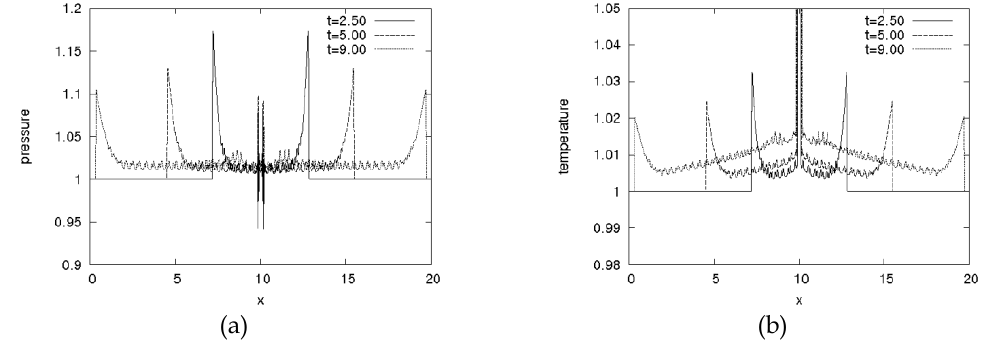
Figure 6 Profiles of pressure (a) and temperature (b) at three time instants